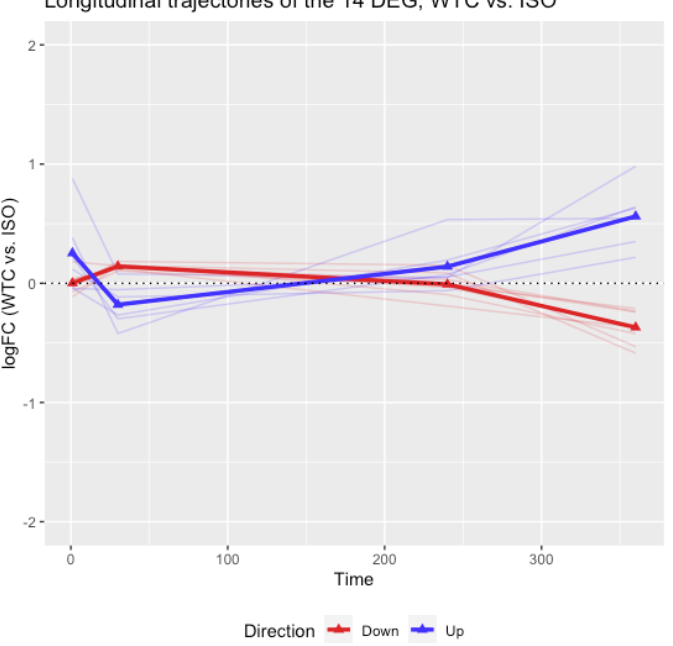
Figure 1. The longitudinal trajectories of logFC between WTC and ISO for the 14 DEGs. The 14 DEGs were identified at day 360 as listed in Table 1. The blue lines referred to DEG up-regulated at day 360, also labeled as ‘Up’, and the red lines referred to DEGs down-regulated at day 360, labeled as ‘Down’. The bold lines connecting the triangles are the mean trajectories.